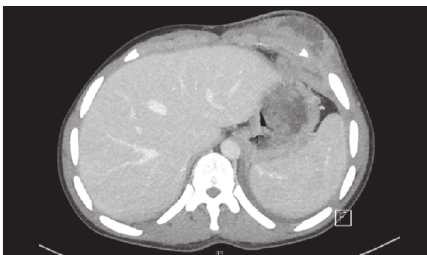
Figure 2: Multiple abscesses on the left chest wall with infiltrations of left ventral ribs.